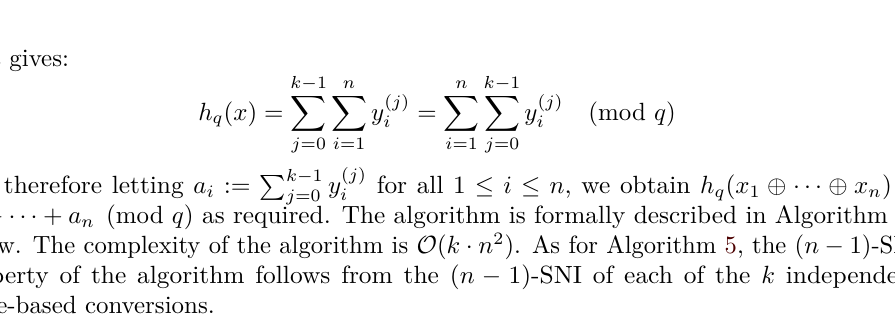
Algorithm 14 Hamming